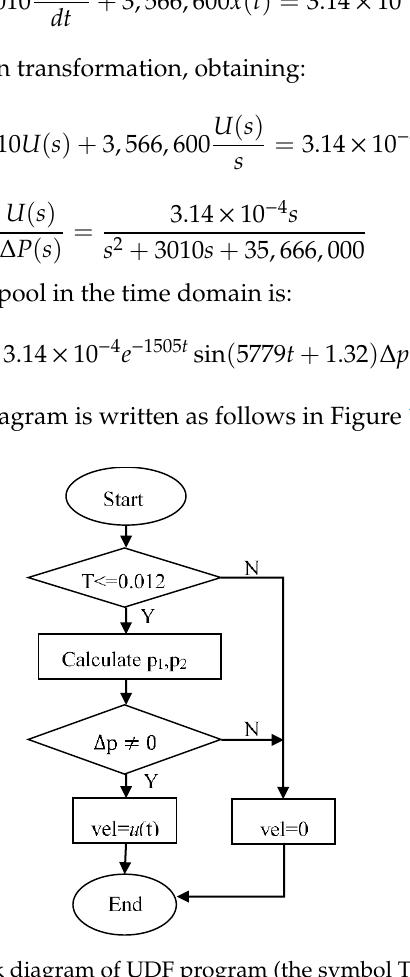
Figure 18. Execution logic block diagram of UDF program (the symbol T means time, and the value 0.012 is the time of the moving grid